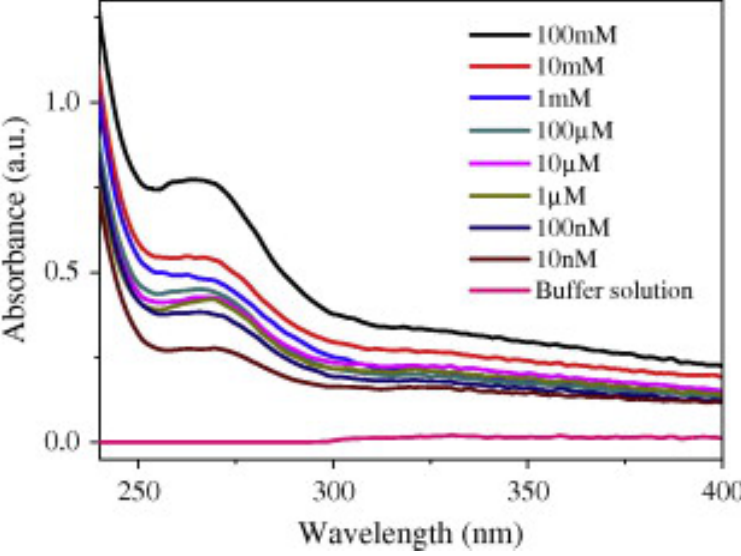
Figure 13. Absorbance spectra of the sensor for glucose concentrations in the range from 10 nM to 100 mM. Reprinted with permission from [107].